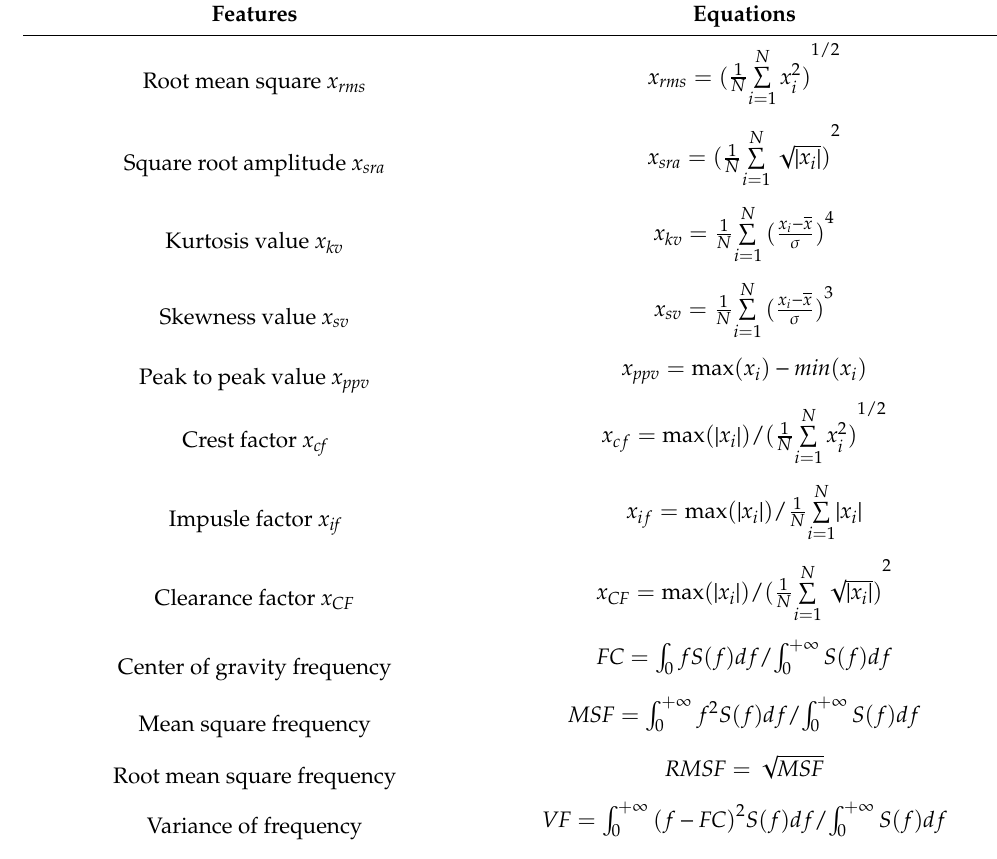
Table 2. Compare the feature set used for verification.